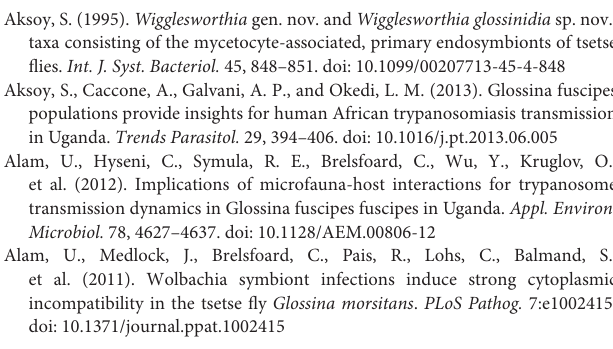
Figure S1 | Rarefaction analysis on the studied samples (Renyi diversity plots); (A) Samples 1–24 and 27–40; (B) Samples 25 and 26 that were processed apart. Figure S2 | Heat map analysis of the distribution and abundance of the bacterial genera in midgut samples. The samples did not cluster together, indicating that the bacterial community among them is highly variable. Sample numbering as in Figure 4 . Figure S3 | Heat map analysis of the repartition and abundance of bacterial species in midgut samples. The samples did not cluster together, indicating that the bacterial community among them is highly variable. Sample numbering as in Figure 4 . Figure S4 | (A) NMDS plot comparing bacterial OTUs in tsetse fly midguts of different foci (Bipindi, Campo, Fontem) using Bray-Curtis dissimilarity indice. (B) NMDS plot comparing bacterial OTUs of infected vs. non infected tsetse fly midguts using Bray-Curtis dissimilarity indice. Figure S5 | Phylogenetic diversity of bacterial 16S rRNA sequences in tsetse fly midguts. NJ tree clustering of OTU representatives based on homology with known sequences is shown. The width of the branch is proportional to the number of samples exhibiting a given OTU. Colors correspond to different phyla. (A–D) Expended scale of four regions from this figure in order to make it easier to read (the corresponding regions are indicated in this